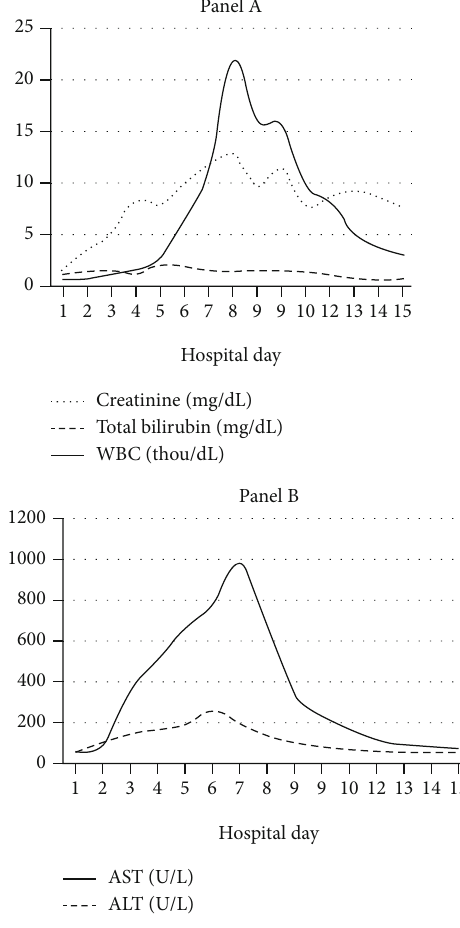
Figure 3: Trends of key lab fi ndings throughout hospital stay. Doxycycline was started on hospital day 3 for suspected ehrlichiosis. The patient had been started on hemodialysis due to acute renal failure on hospital day 4 and was taken o ff on day 10 due to marked clinical improvement. The progression of creatinine (mg/dL), WBC count (thou/mcL), and total bilirubin (mg/dL) over his hospital stay is seen in (a). The progression of AST (U/L) and ALT (U/L) over his hospital stay is seen in